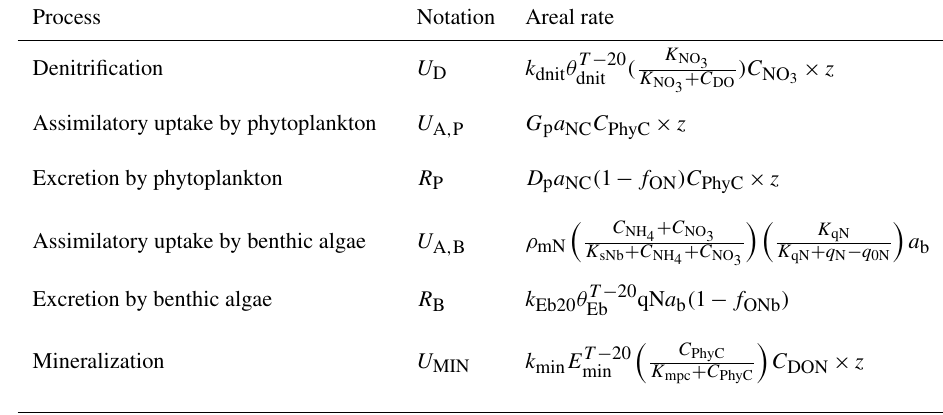
Table 1. Areal rates (in gNm − 2 d − 1 ) of DIN-related processes in the advanced eutrophication module of WASP 7.5.2 ∗ .